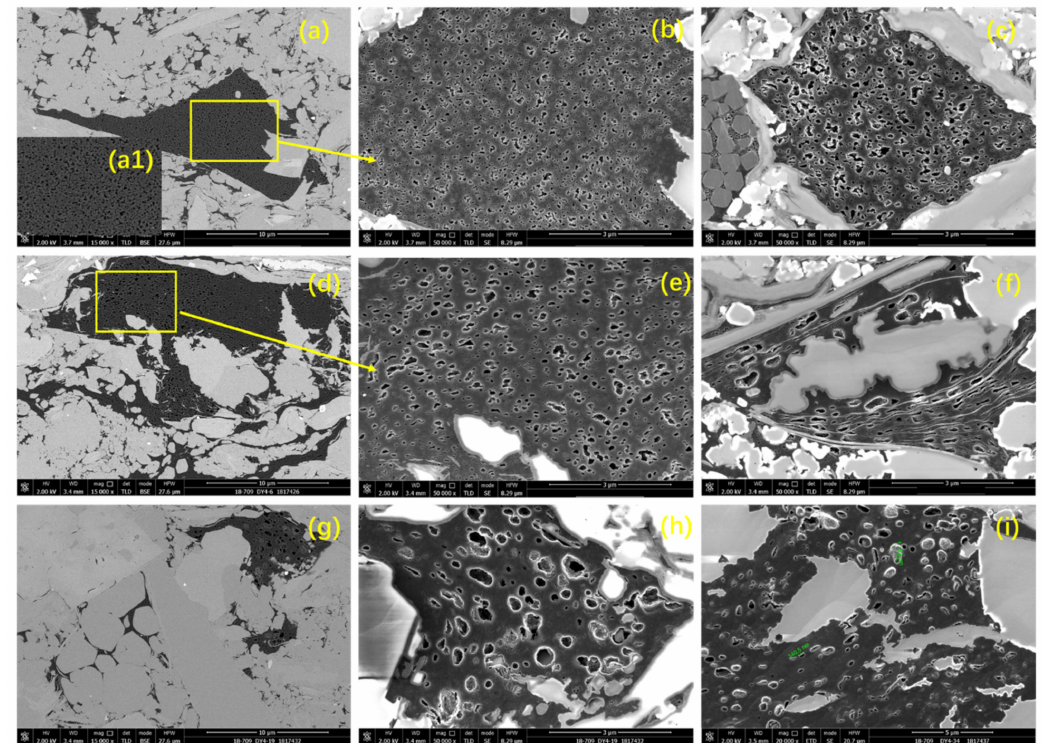
Figure 11. Microphotos under scanning electron microscope (SEM), showing abundant pores with nanometers to micrometers developed in organic matter. ( a – e ): Pores in original kerogen organic matter residues (A type), ( a1 ) showing that pores were irregular and small. ( f – i ): Pores (B type, elliptical and near circular) in the migrated solid bitumen which filled in the holes among mineral particles, micro-fractures along bedding or interlayer fractures in clay minerals (e.g., illite, Figure 11f).